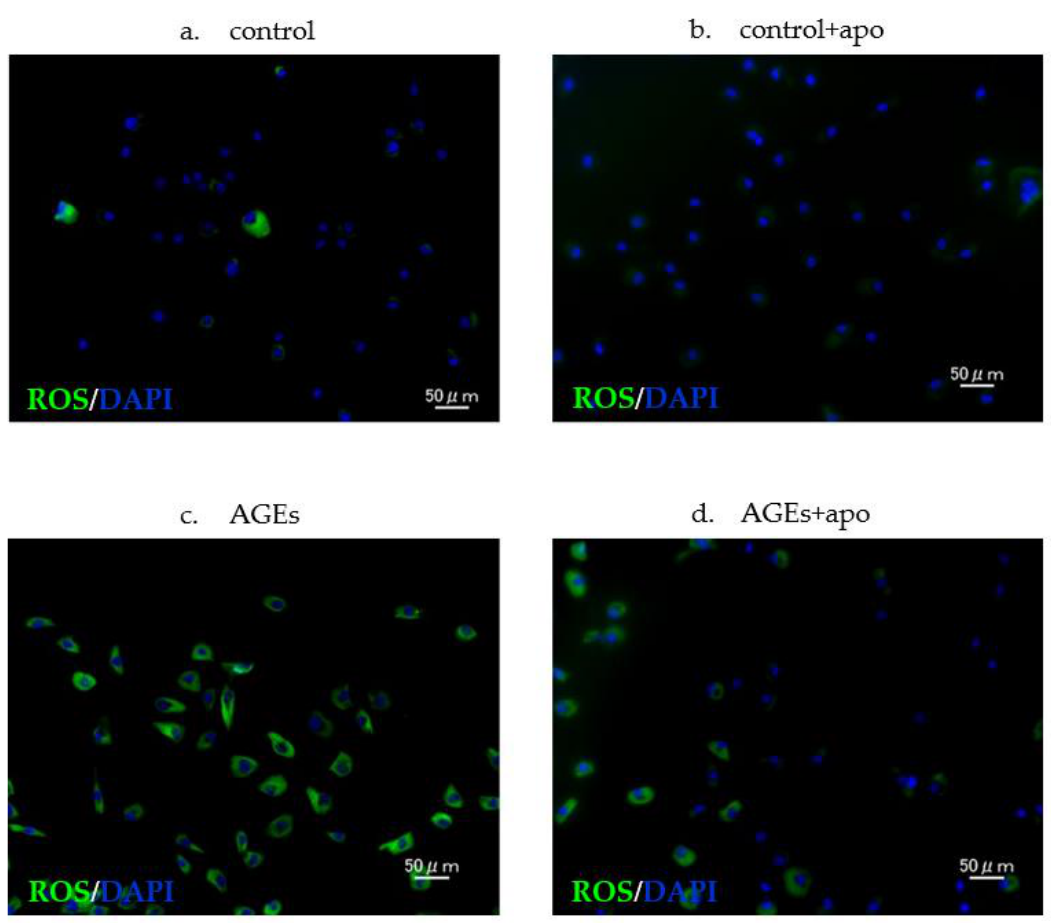
Figure 5. Fluorescence staining showing ROS. ROS production in rotator cuff-derived cells and nuclei (DAPI) (blue). ( a , b ) Low ROS production was observed in control + apo groups; ( c , d ) increased ROS production was observed in the AGEs group and the AGEs + apo group compared to the control and control + apo groups. ROS production was decreased in the AGEs + apo group compared to the AGEs group.